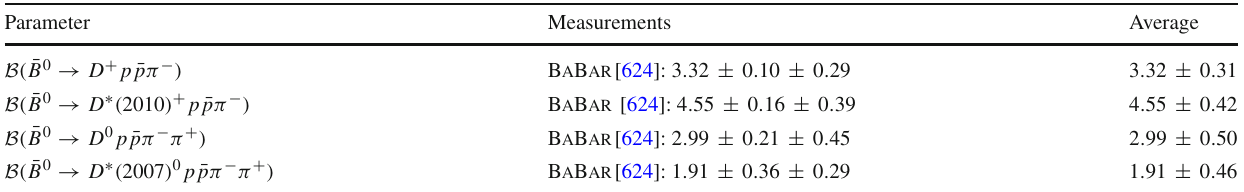
Table 104 Baryonic decays I [ 10 − 4 ]